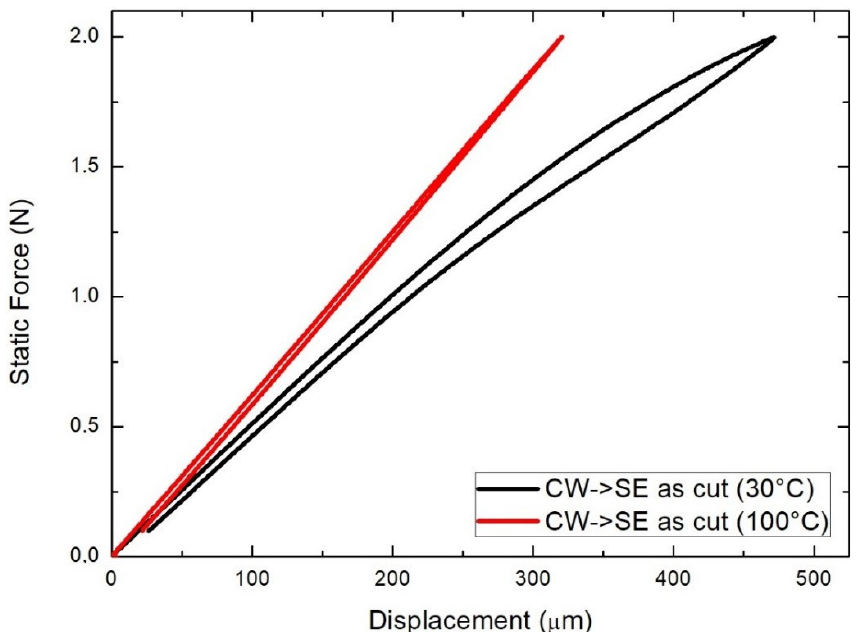
Figure 12. Static force/displacement curve for a diamond-like element cut from CW sheet at low (30 °C) and high (100 °C) temperatures.